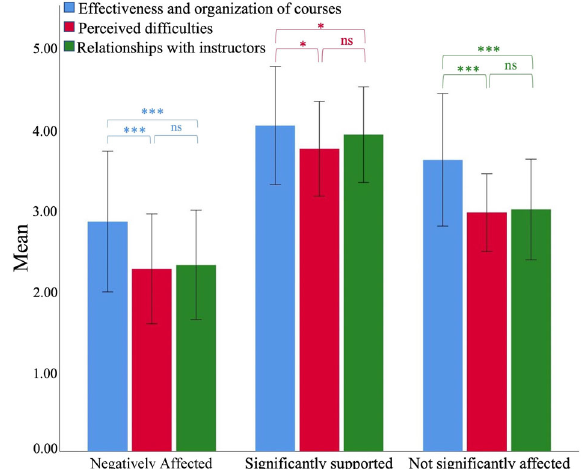
FIG. 2. Mean values of the raw scores of the three SWB profiles for the three latent dimensions of the emergency remote in- struction perception. Whiskers are standard